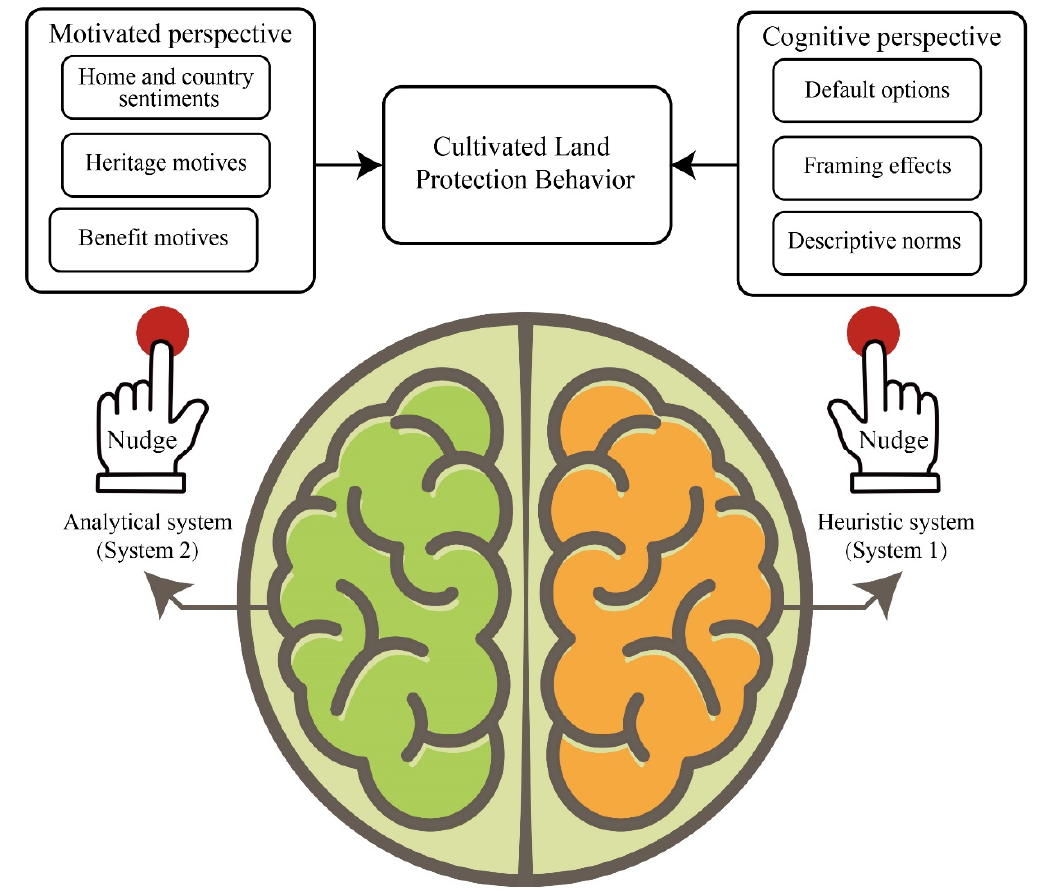
Figure 1. Nudging Strategies for Arable Land Protection Behavior in China.